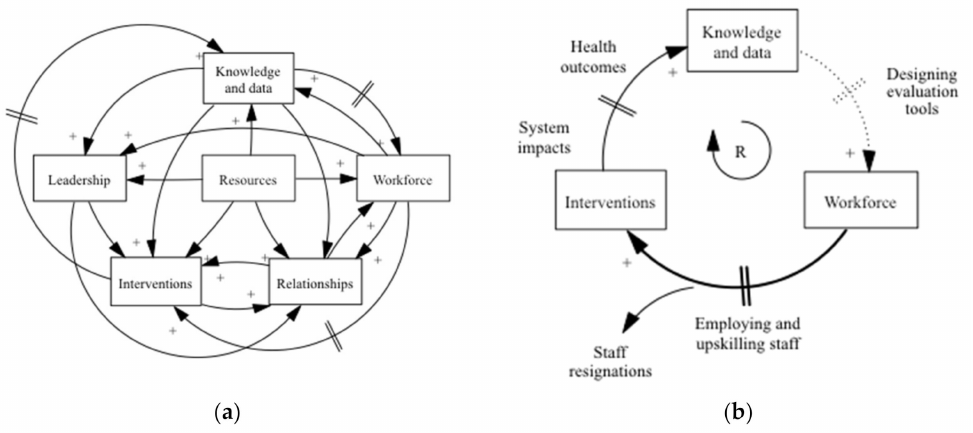
Figure 1. Healthy Together Victoria prevention system: in practice. ( a ) A causal loop diagram of the HTV prevention system building blocks. ( b ) The core feedback loop of the prevention system, excerpt from ( a ). Key: // a